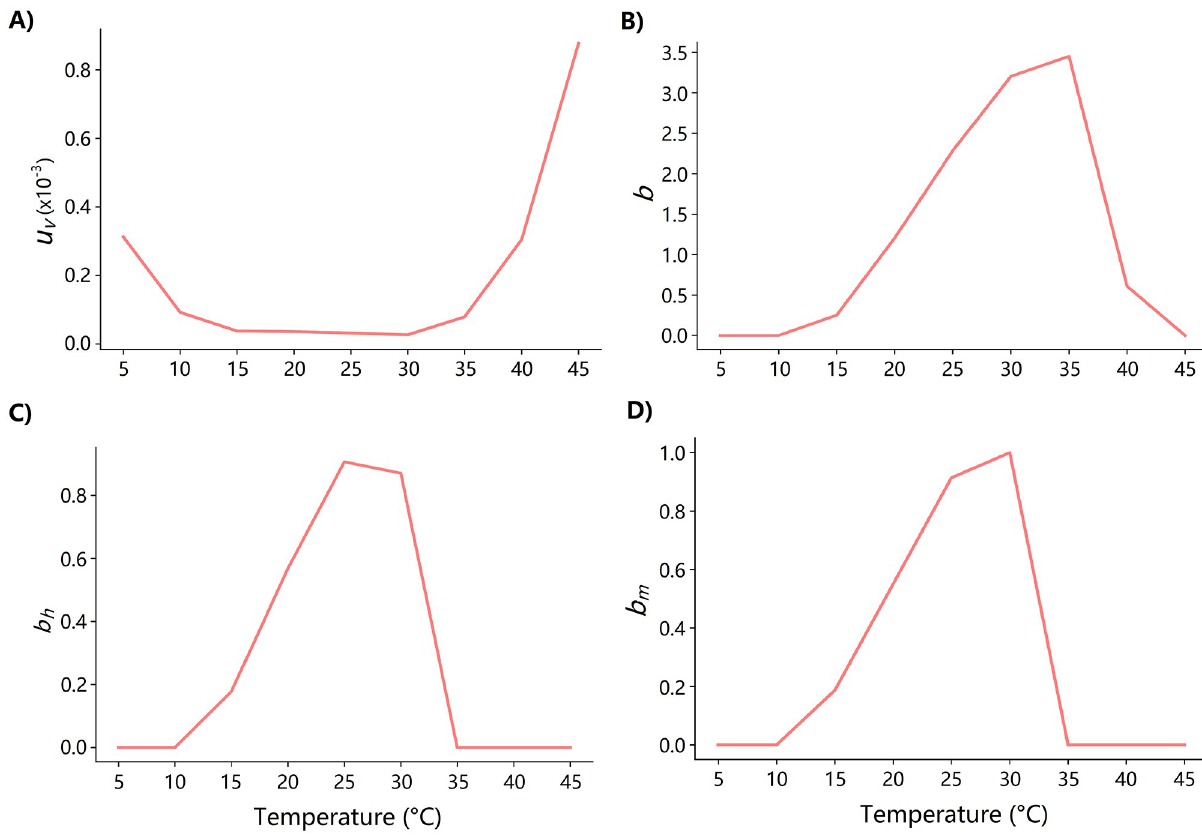
Fig 4. Temperature-based functions for (a) μ , (b) b , (c) b